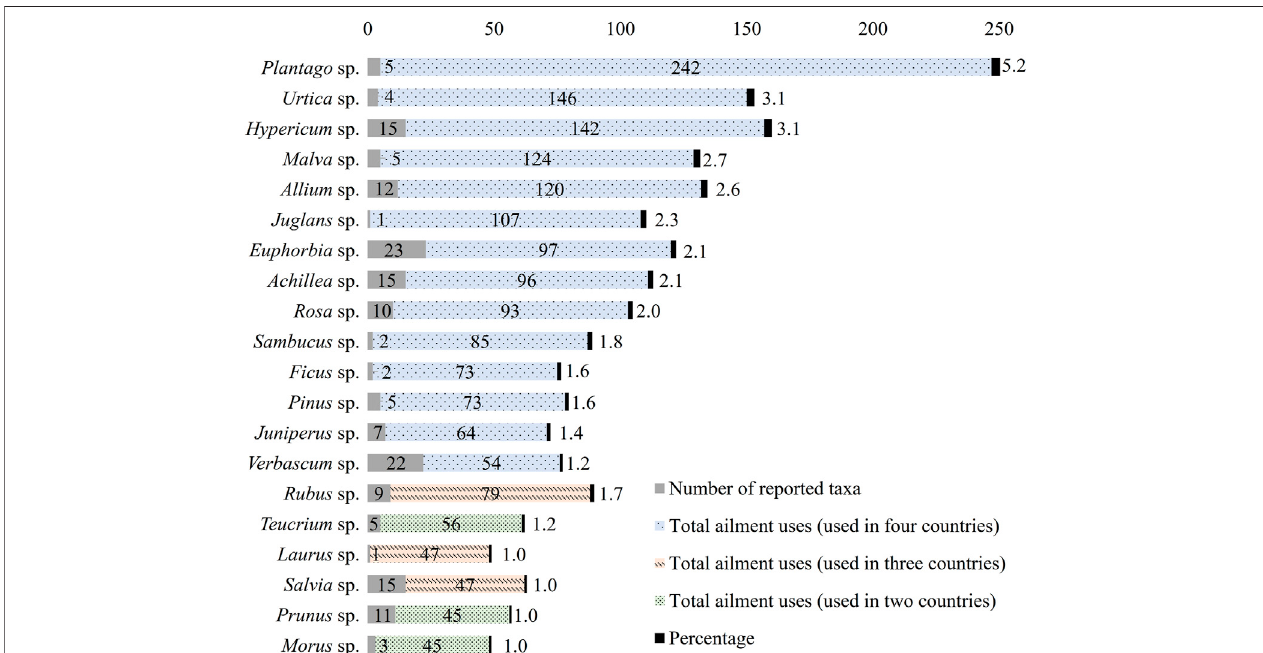
FIGURE 5 | Most cited genera in relation with their corresponding taxa.